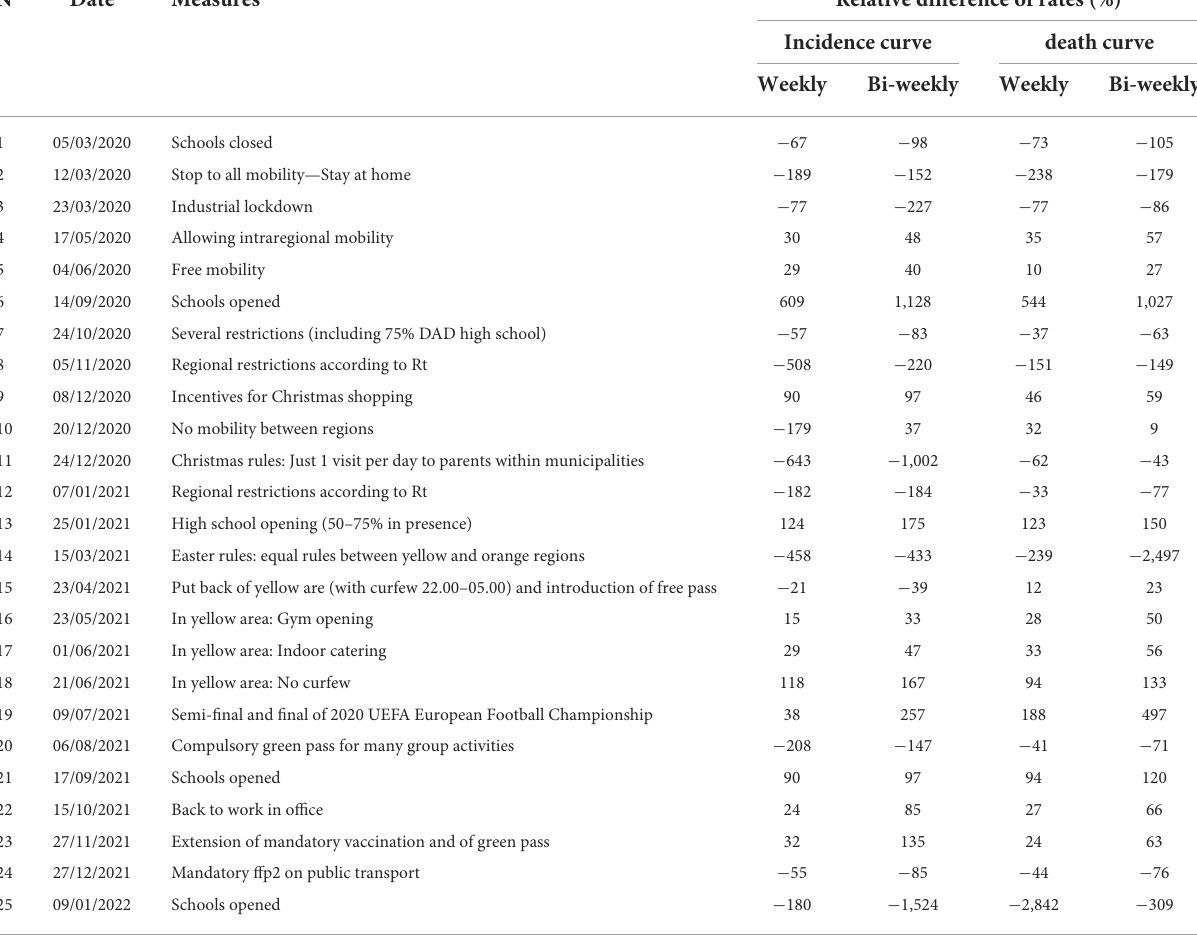
TABLE 2 Differences in rates of COVID-19 incidence and death curves before and after prevention measures. N Measures Relative difference of rates (%) Incidence curve death curve